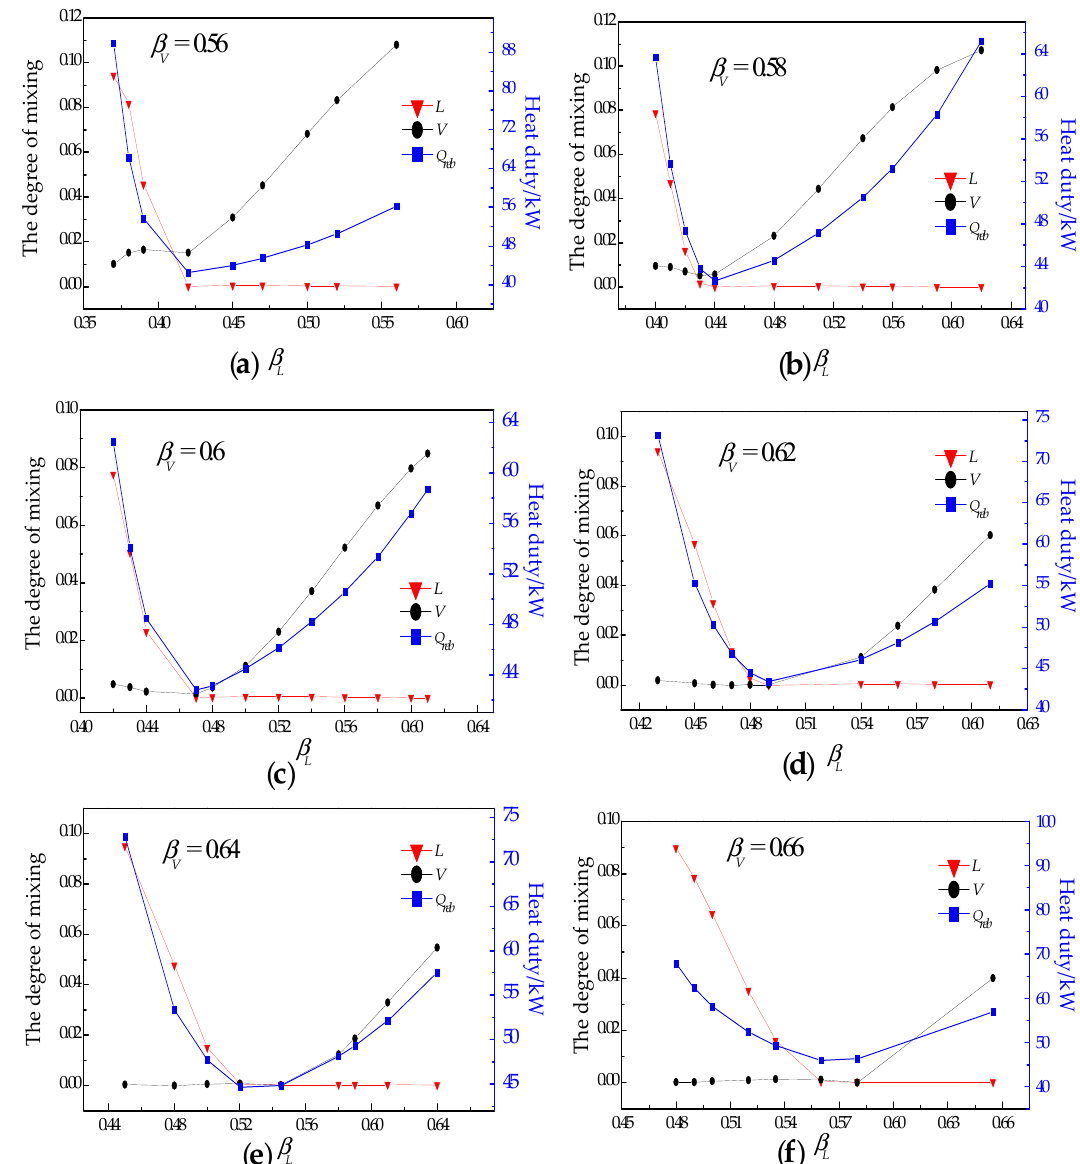
Figure 15. The effects of mixing and heat duty of reboiler versus liquid split ratio under different vapor split ratios. L , the liquid mixing effects at the bottom of the dividing wall; V , the vapor mixing effects at the top of the wall; Q reb , the heat duty of the reboiler: (a) β V is fixed at 0.56; (b) β V is fixed at 0.58; (c) β V is fixed at 0.60; (d) β V is fixed at 0.62; (e) β V is fixed at 0.64; (f) β V is fixed at 0.66.